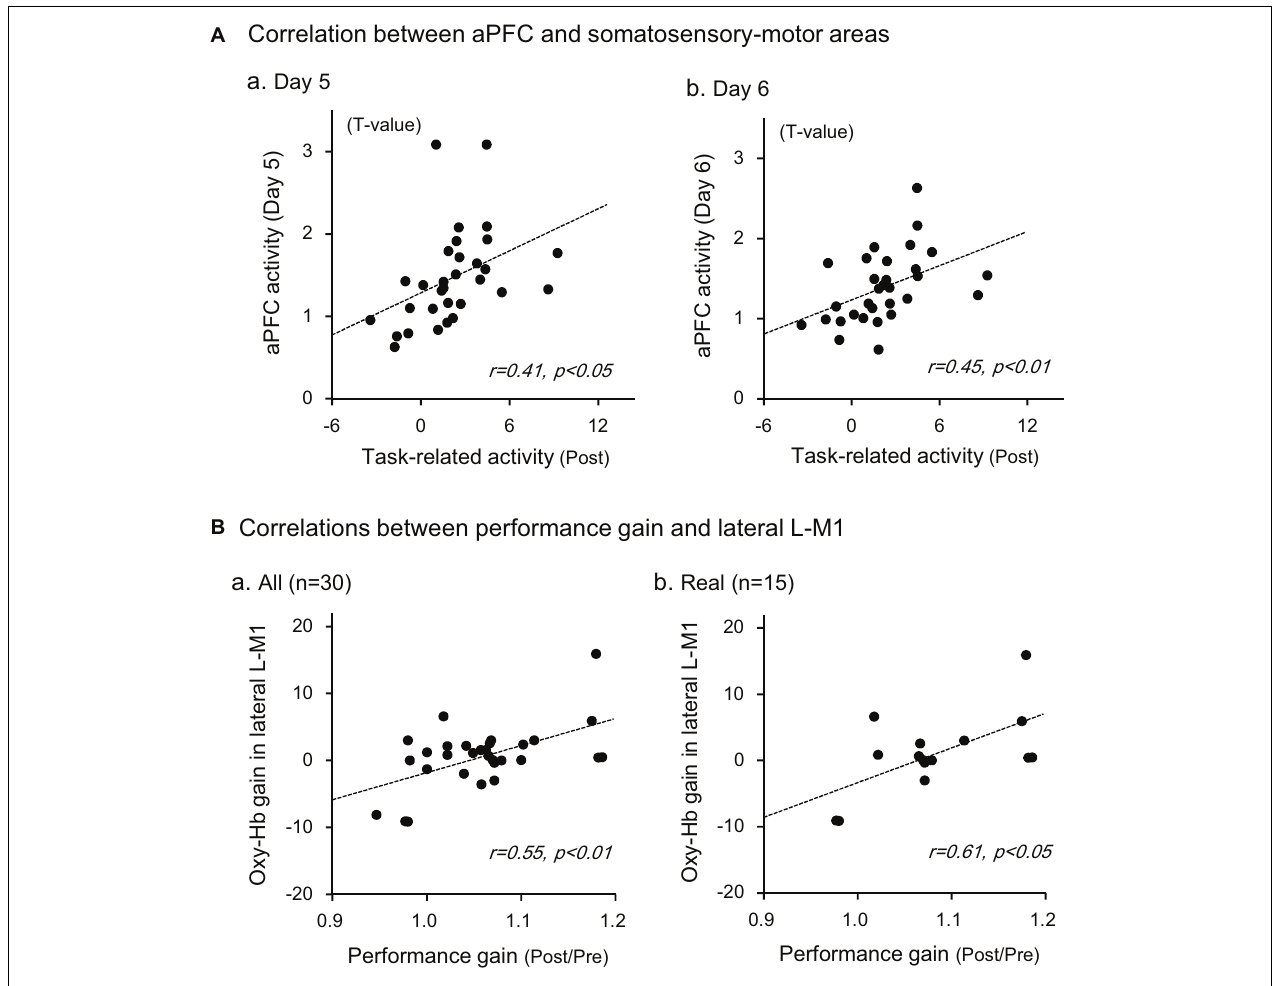
FIGURE 7 | Relationships between aPFC activity during motor imagery training and activity in the somatosensory motor-related areas during the Purdue Pegboard test (A) , and those between Oxy-Hb gain in the lateral L-M1 and performance gain in the Purdue Pegboard test (B) . (A) There were significant positive correlations between the activity in the somatosensory motor-related areas and that in the aPFC on day 5 (a) and day 6 (b) . (B) There were significant positive correlations between Oxy-Hb gain in the lateral L-M1 and hand performance gain in the Purdue Pegboard test when data in the whole subjects (a) and subjects in the real group (b) were analyzed. The data in each circle indicate data from each